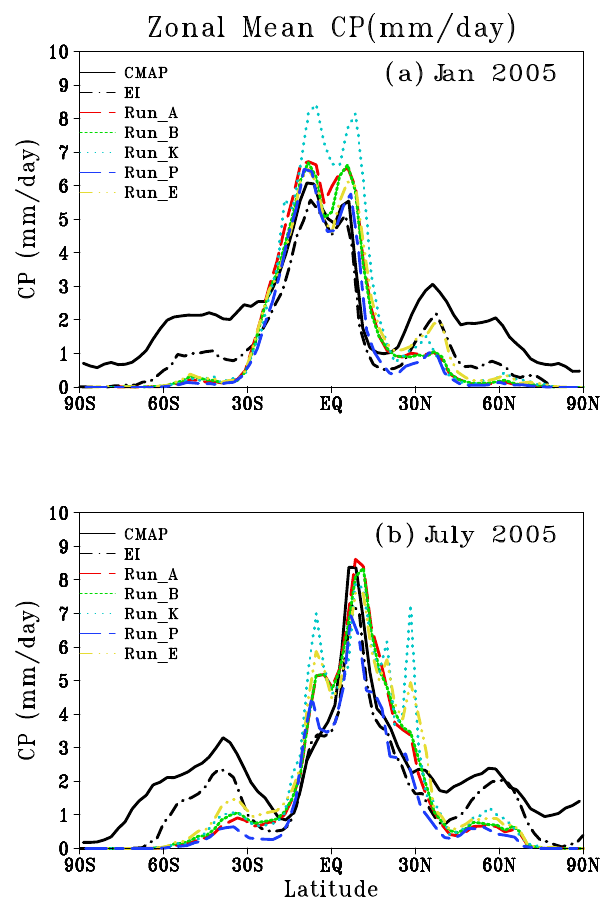
Fig. 11. Zonal mean convective precipitation (mm/day) from CMAP data, ERA-Interim reanalyses and model runs “A E40”, “B EI”, “K L31”, “P det” and “E EInewevap” for (a) January 2005, and (b) July 2005.